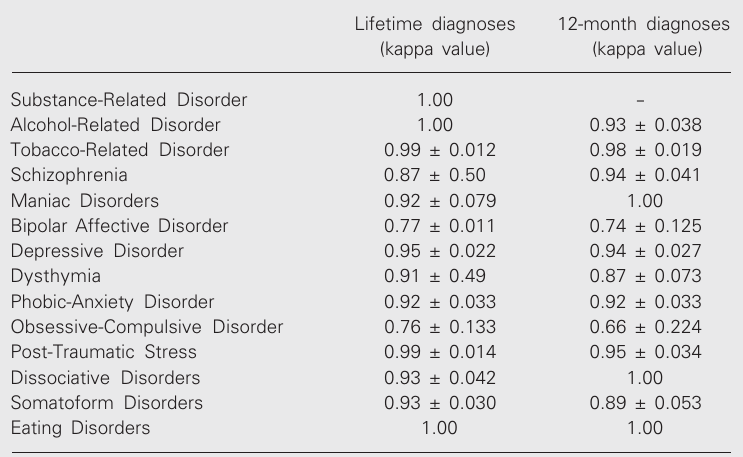
Table 2. Diagnostic reliability of the Brazilian version of the CIDI